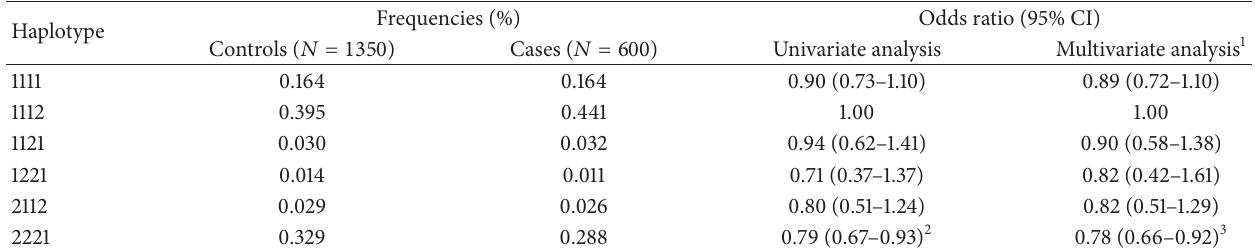
Table 2: Haplotypes and associated risk for type 2 diabetes mellitus.